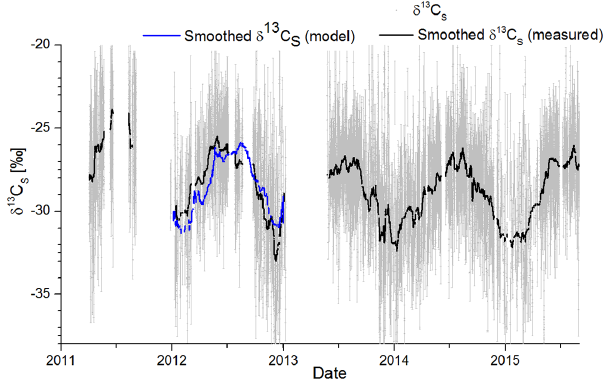
Figure 4. Moving Keeling plot method-based source signature in Heidelberg from 2011 until mid-2015. The black line is the smoothed measured source signature, and the blue line gives the smoothed modeled source signature (both 50th-percentile filter with window size = 100h). Half a window size before the beginning of a large data gap the data are not further smoothed to prevent smooth- ing